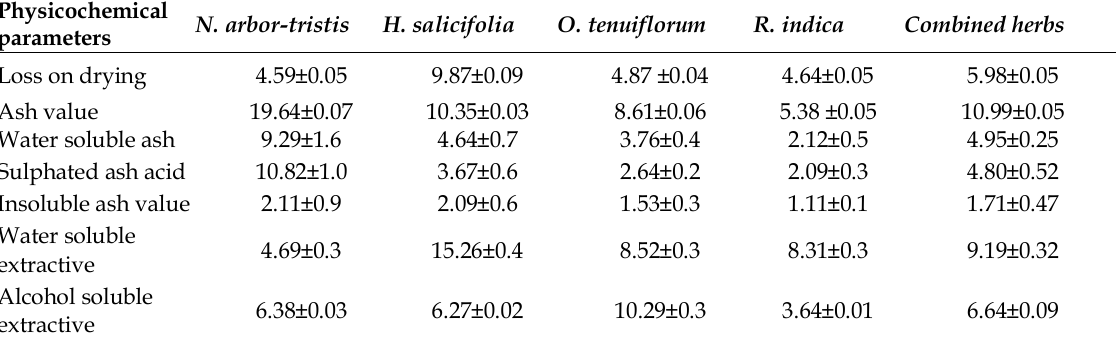
Table 1 : The Physicochemical analysis of N. arbor-tristis, H. salicifolia, O. tenuiflorum and R. indica . Physicochemical